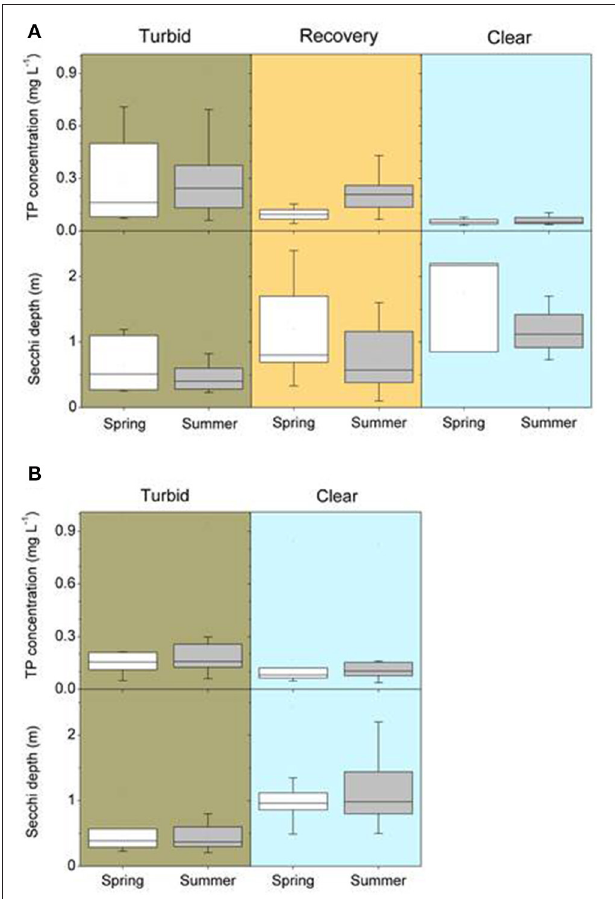
FIGURE 2 | Total phosphorus (TP) concentrations and Secchi depth in spring (April–June) and summer (July–September) of different north temperate shallow lakes (A) before and after external nutrient load reductions during the turbid, the intermediate recovery and the clear-water state (for details see Table 1 ) and (B) before (turbid) and after (clear) biomanipulation or other lake-internal measures (for details see Table 2